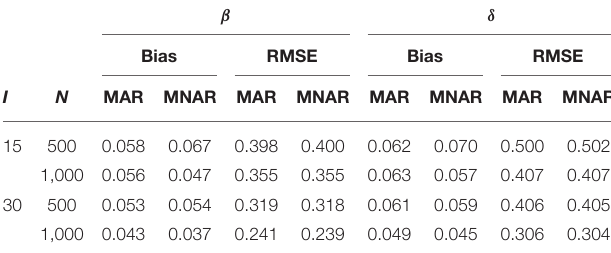
TABLE 1 | Summary of the item parameters for high missingness